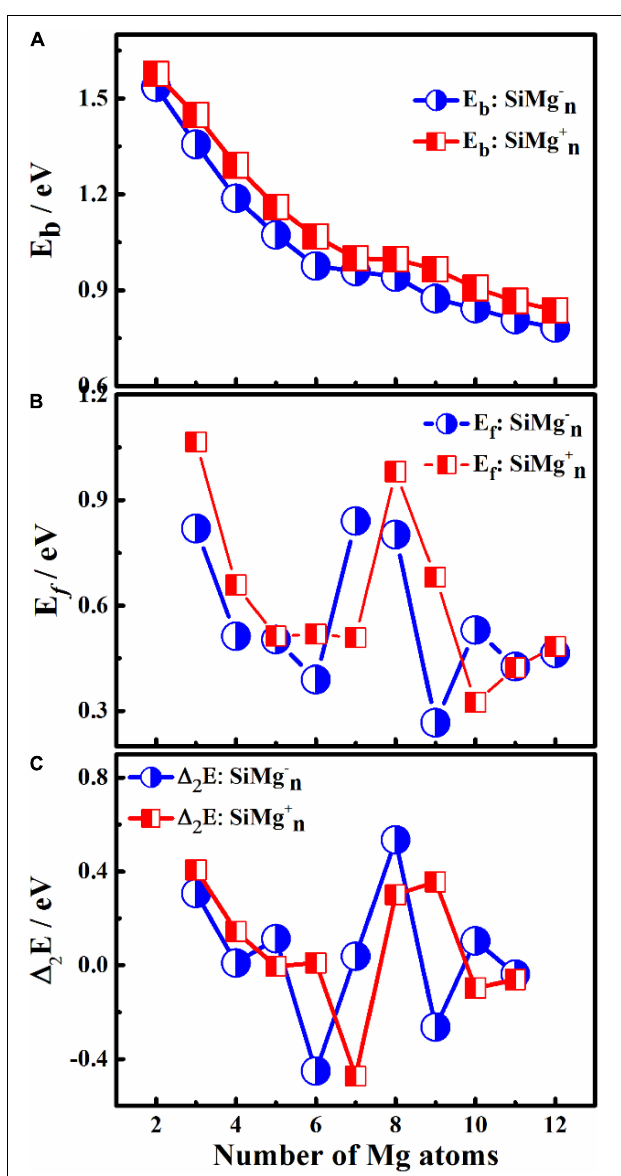
FIGURE 4 | Size-dependent properties of panels (A) E b , (B) E f , and (C) (cid:49) 2 E for the ground state of SiMg ± 1 n ( n = 2–12) clusters.